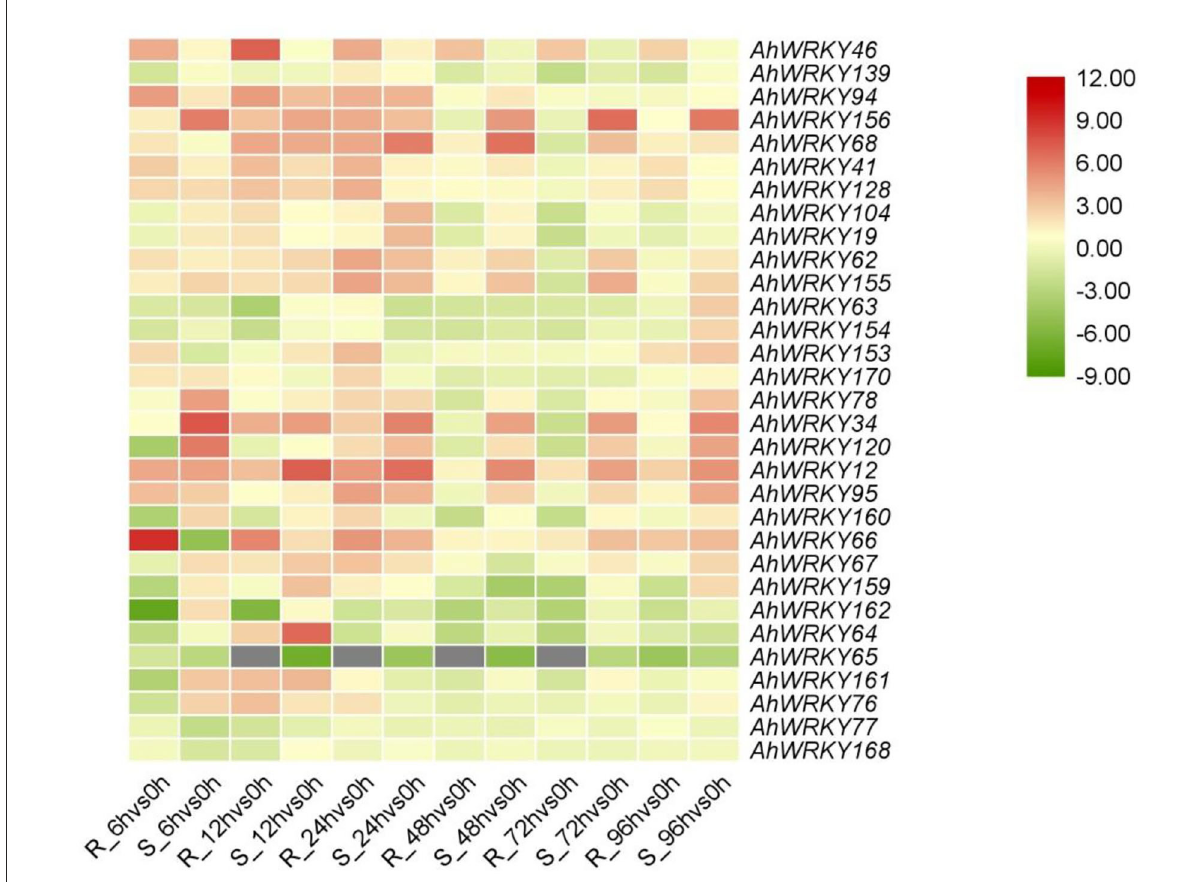
FIGURE7 Expression of AhWRKYs in the two cultivars infected with Ralstonia solanacearu m. The qRT-PCR of each gene in peanut roots infected with Ralstonia solanacearu m in the two cultivars is shown. Heatmap showed the log2-transformed ratio values. R, Resistance; S,